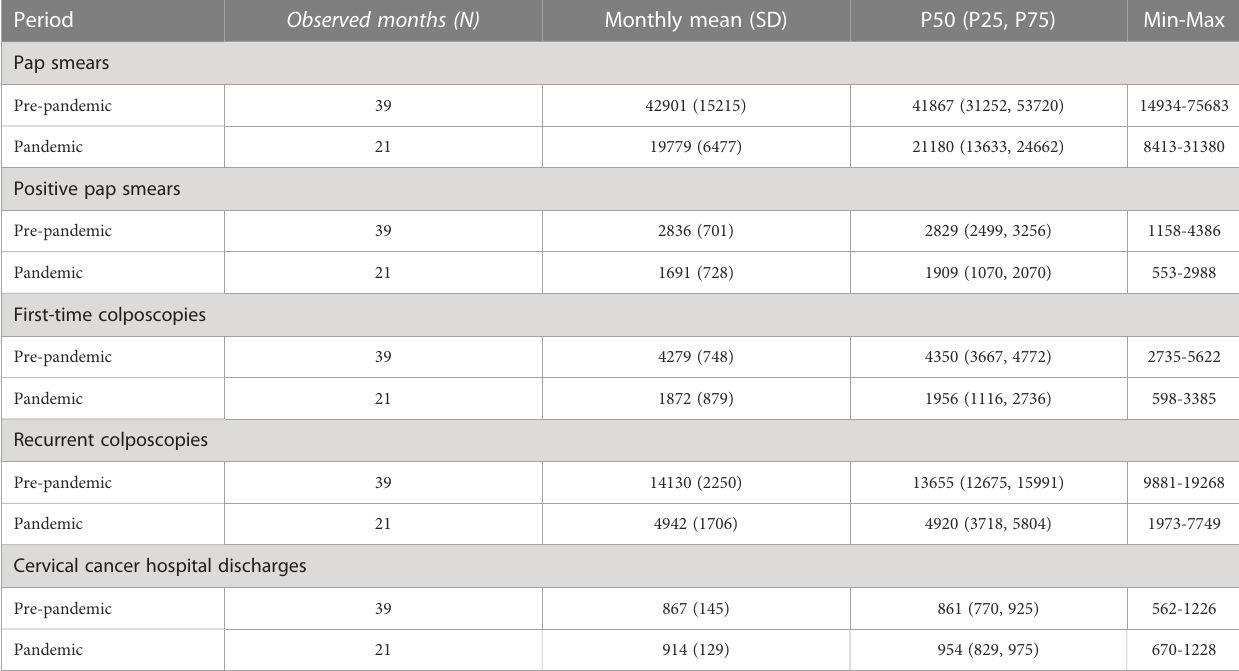
TABLE 1 Descriptive statistics of monthly data of selected indicators of the CC